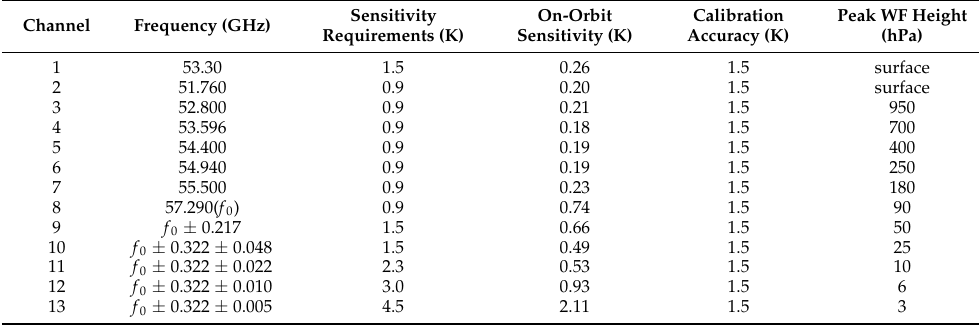
Table 2. Channel characteristics of